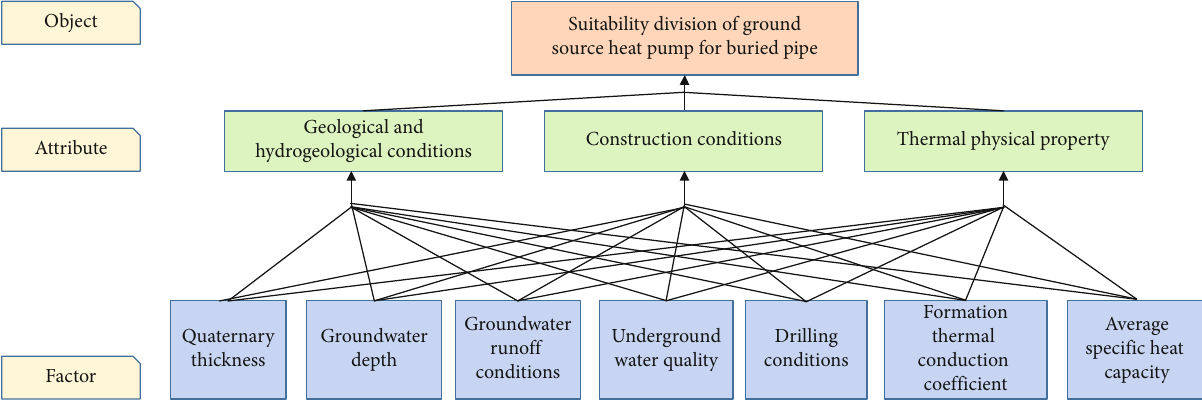
Figure 8: Structural diagram of the hierarchical analysis model of the ground source heat pump of the buried Table 2: Weight of suitability of the groundwater ground source heat pump.